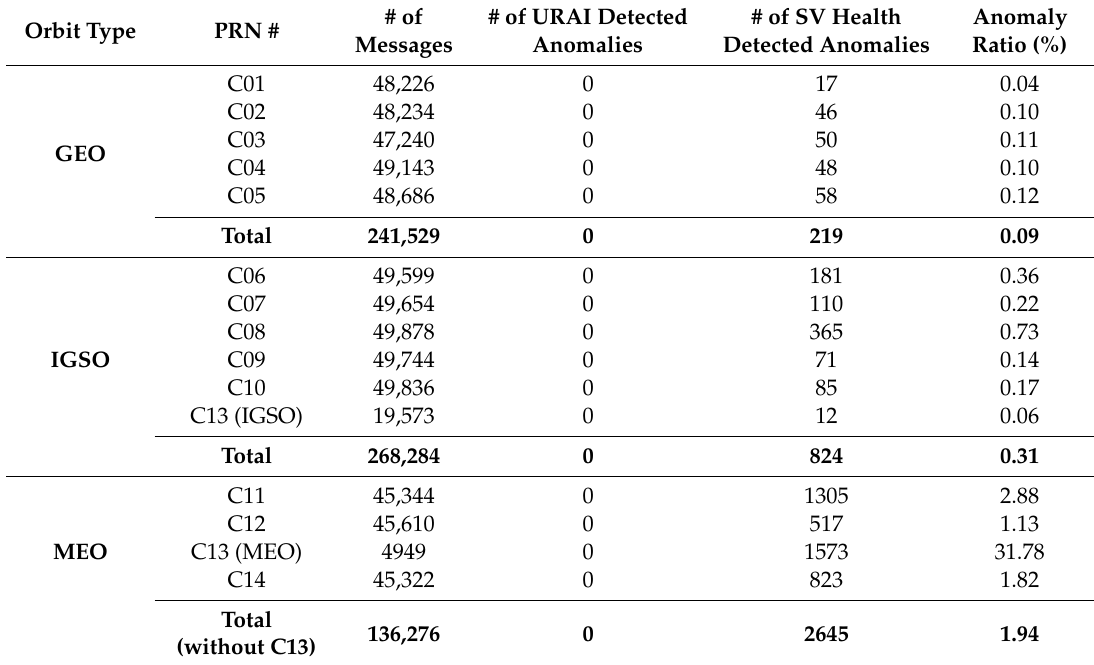
Table 1. BDS-2 anomalies detected by the URAI and SV health.